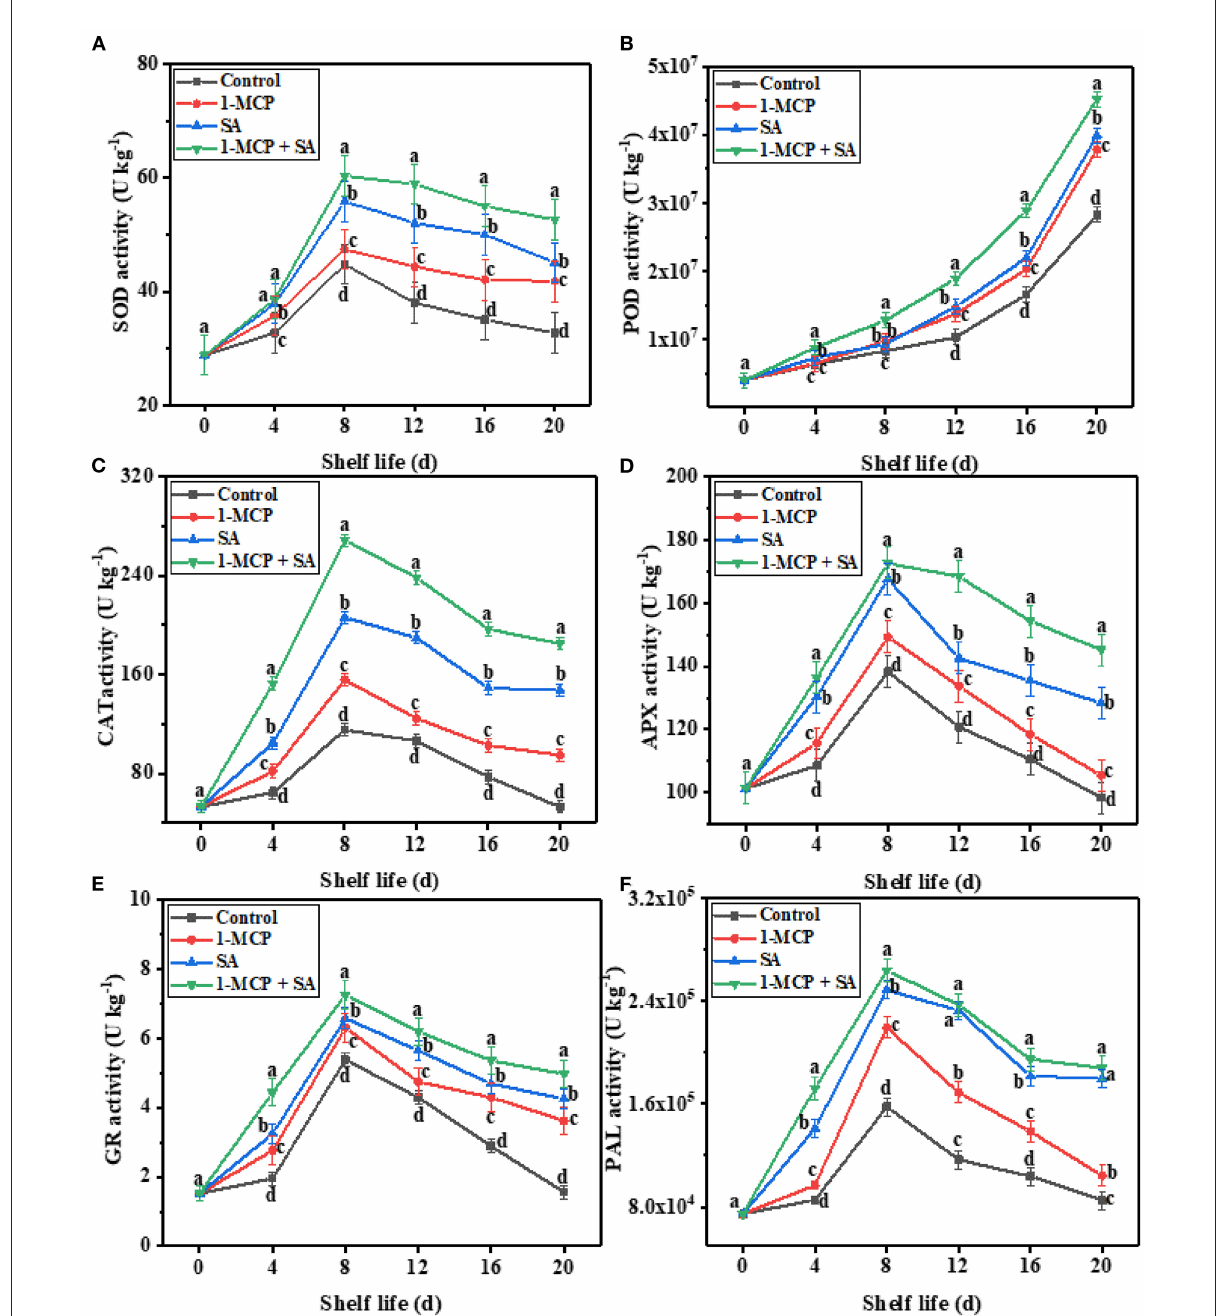
FIGURE5 Effects of 1-methylcyclopropene (1-MCP), salicylic acid (SA), and 1-MCP and SA combined treatments on SOD (A) , POD (B) , CAT (C) , APX (D) , GR (E) , and PAL (F) activities of winter jujube during shelf life at 4 ± 1 ◦ C for 20 d. SOD, superoxide dismutase; POD, polyphenol oxidase; CAT, catalase; APX, ascorbic acid peroxidase; GR, glutathione reductase; PAL, phenylalanine ammonia-lyase. The data presented are the mean values of three replicates; vertical bars represent the standard errors of the mean values; values followed by different superscripts (a-d) are significantly different ( P < 0.05) on the same sampling